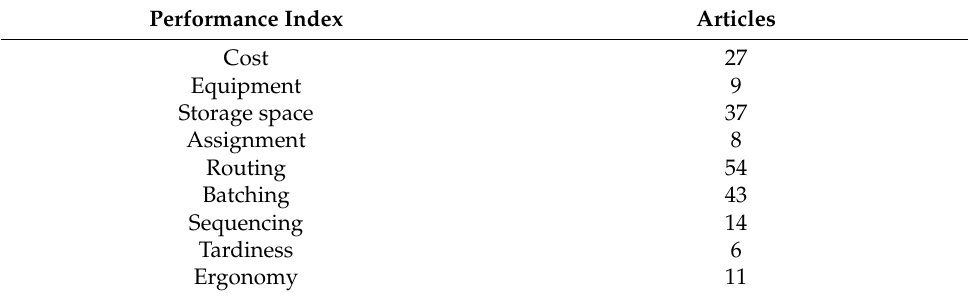
Figure 7. Frequency of study areas examined in this study. Table 3. The Picking Process Components Study